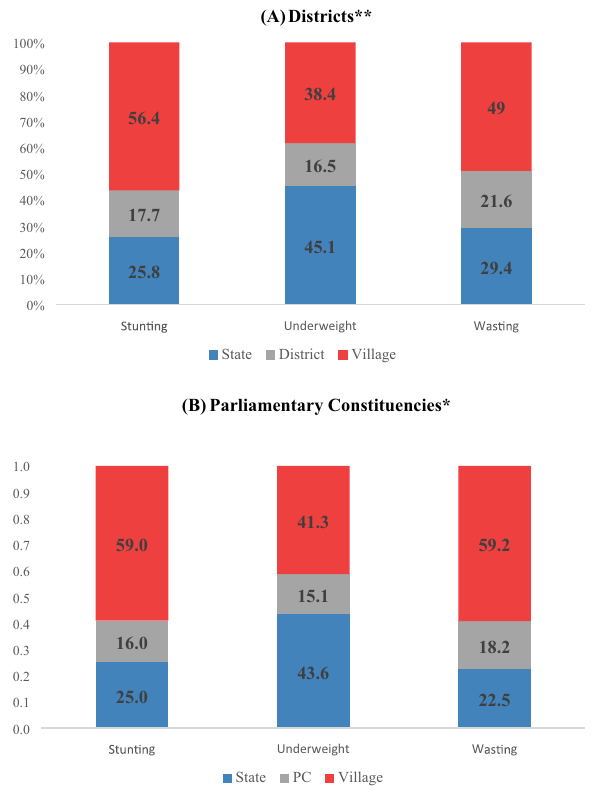
Figure 1. Partitioning variation in child anthropometric failures (0–59 months) by multiple geographies, India, NFHS 2016. Note: The exact variance estimates are reported in supplementary Table